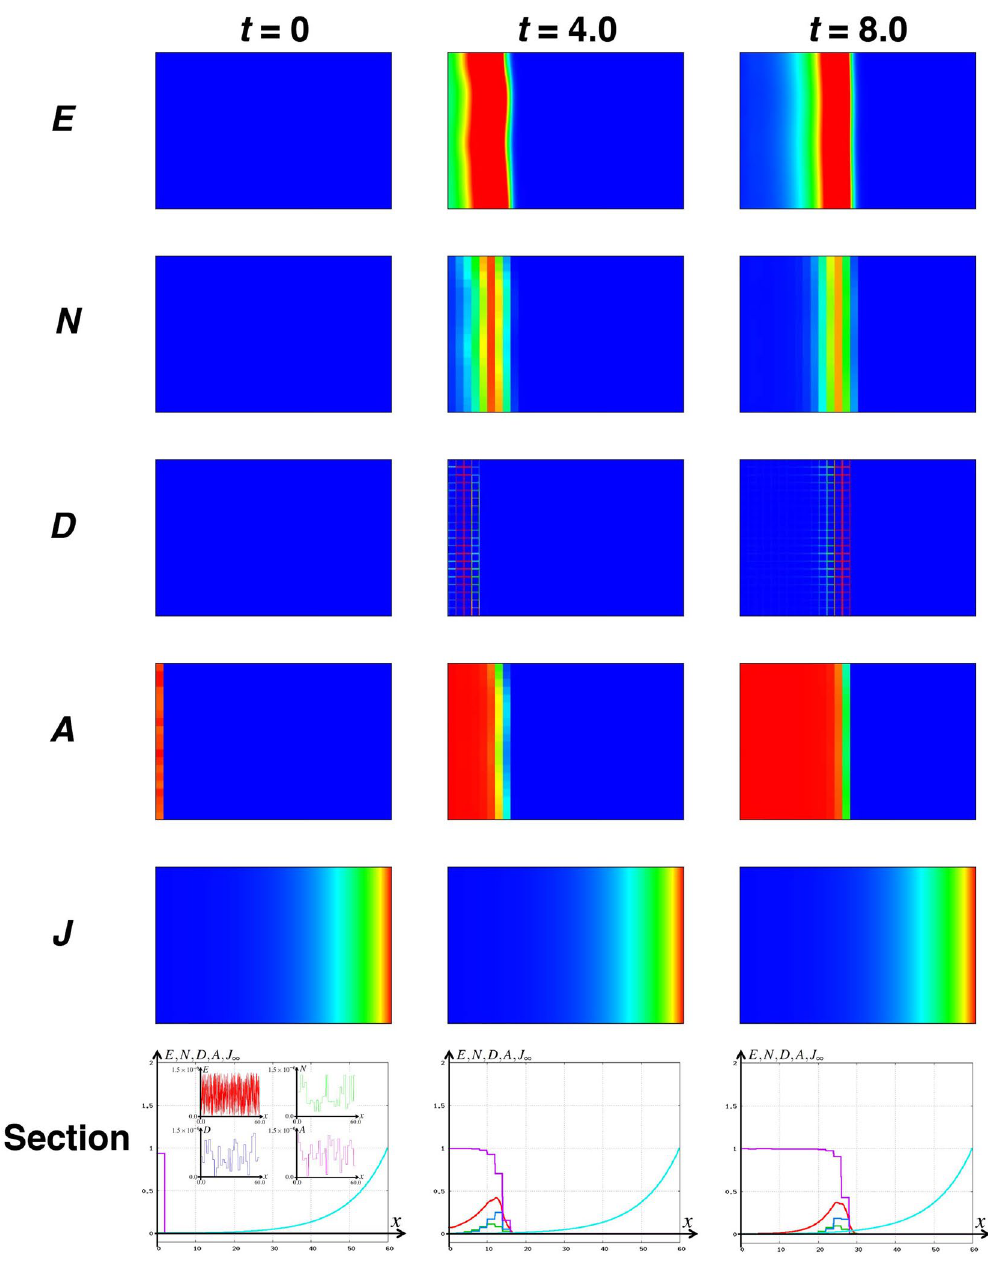
Figure 3. JAK/STAT signaling cancels the noise in silico . The result of the numerical simulation of Model 2 in the field B with the same parameters as in Fig. 2 and k in = 1.0, d i = 1.0, k i = 0.01, J 0 = 1.0. The five upper figures show the profiles of the E , N , D , A , and J in the field B , and the lowest panels show the longitudinal section, where red, green, blue, magenta, and light blue curves correspond to the values of E , N , D , A , and J ∞ on [0, L x ] and y = L y /2 . The columns from left to right show the profiles of t = 0, t = 4.0, and t = 8.0, respectively. The insets in the longitudinal section at t = 0 are enlarged views of E , N , D , and A at t = 0, and similar noise is added in each step in the numerical